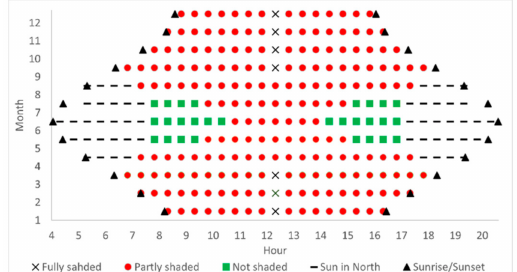
Figure 8. State of shading: north-facing surface, latitude 52.21 ◦ N, D = 20 m, H = 20 m, L = 40 m.